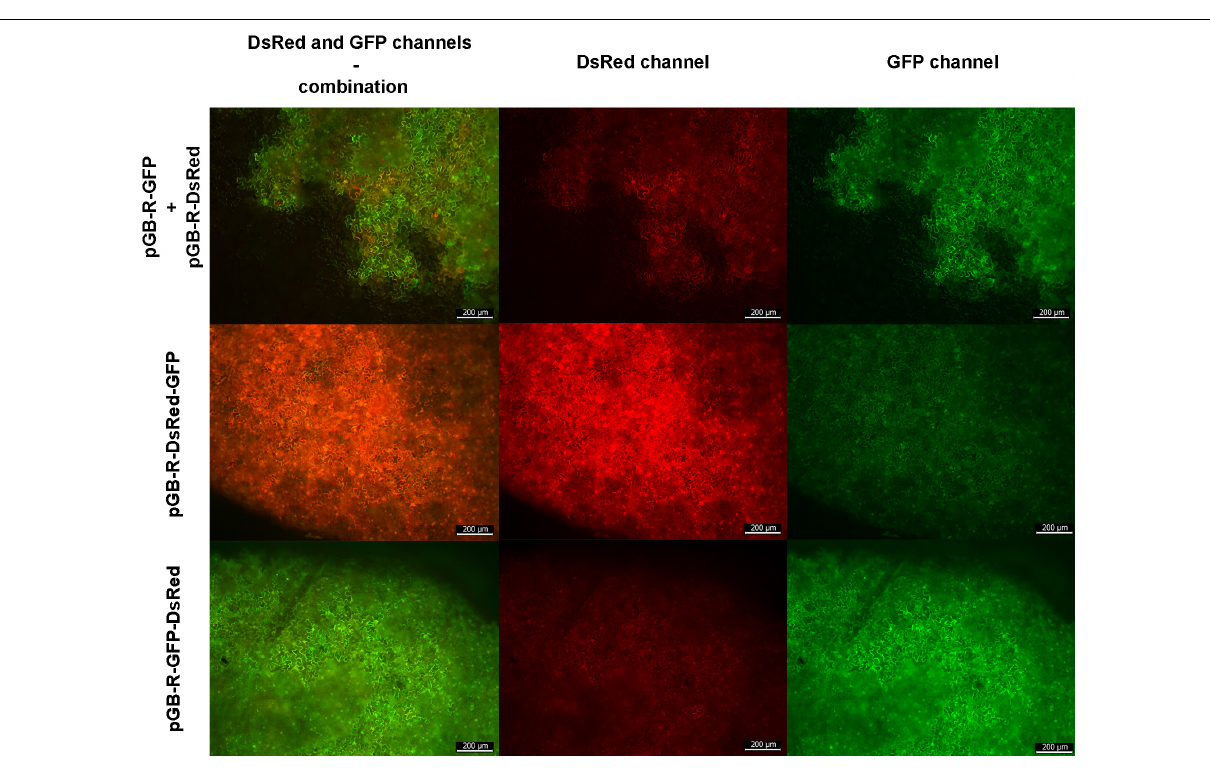
Frontiers in Plant Science |